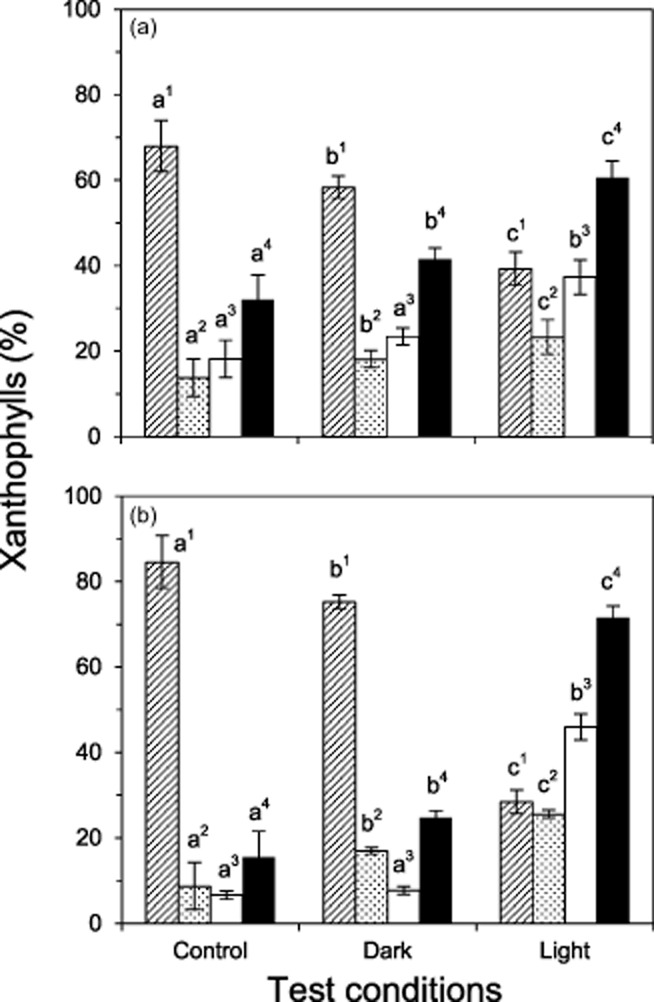
Xanthophyll cycle pigments following controlled sublethal heat stress. Violoxanthin (hatched bars), antheraxanthin (dotted bars) and zeaxanthin (white bars) in (a) Senecio incanus and (b) Ranunculus glacialis, expressed as a percentage of total xanthophyll cycle pigments, and their de-epoxidation state (A + Z)/(V + A + Z)·100% (black bars) immediately following the termination of controlled, in situ heat treatments (S. incanus: 44 °C, Ra. glacialis: 41 °C) in the dark mode and in the light mode are shown in comparison with untreated plants (control). Significant differences between the individual pigments (superscript numbers) are indicated by different letters (one-way anova, Duncan's test, P < 0.05)